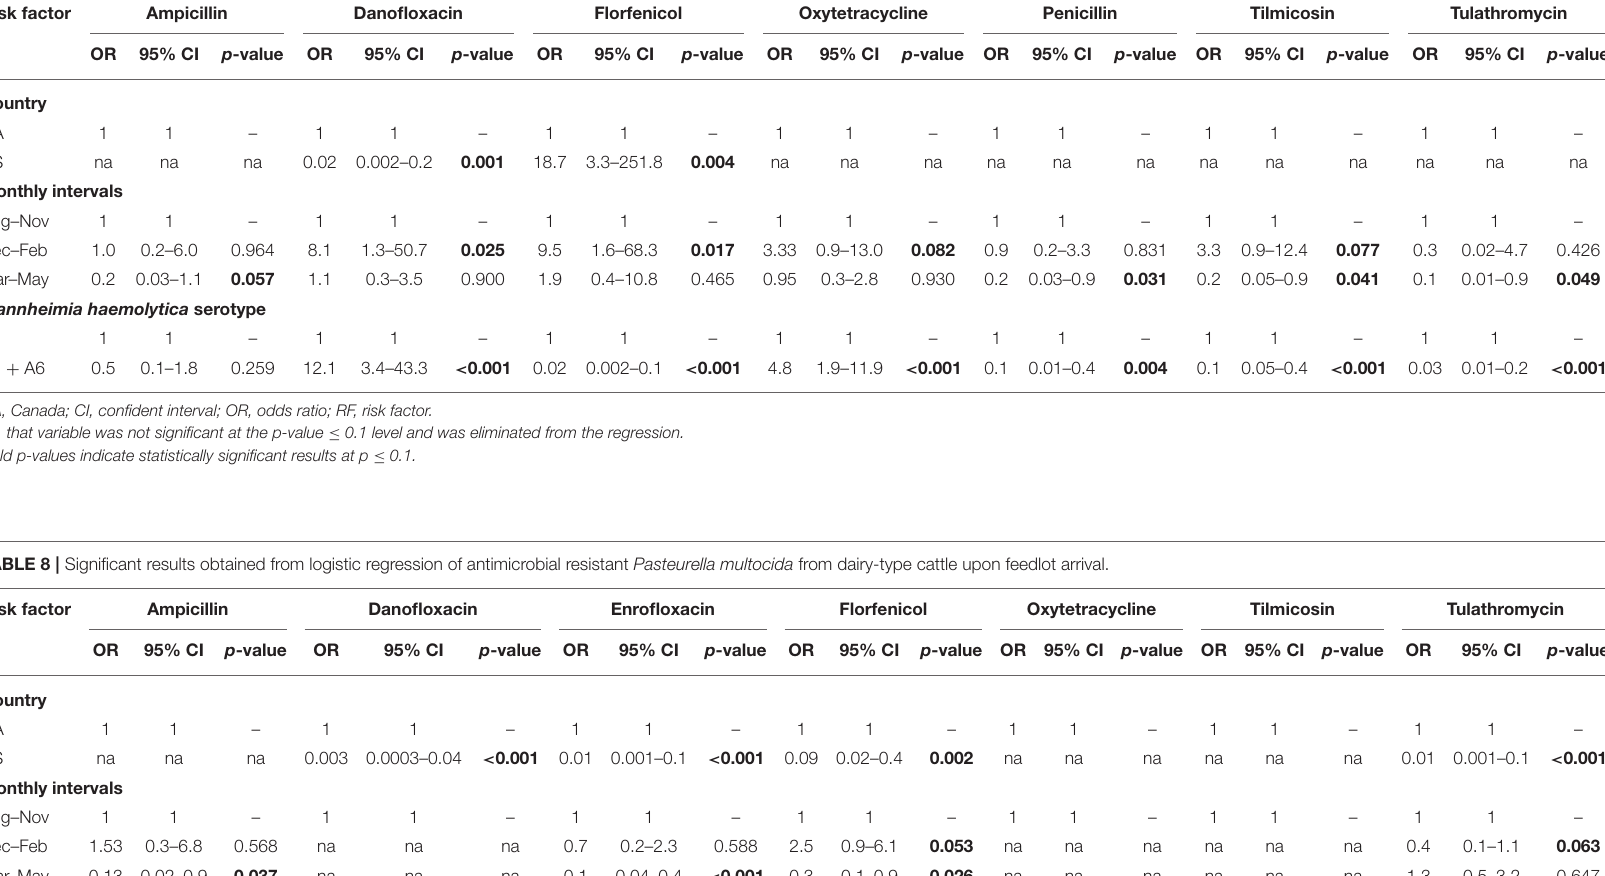
TABLE 7 | Significant results obtained from logistic regression of antimicrobial resistant Mannheimia haemolytica from dairy-type cattle upon feedlot arrival. Risk factor